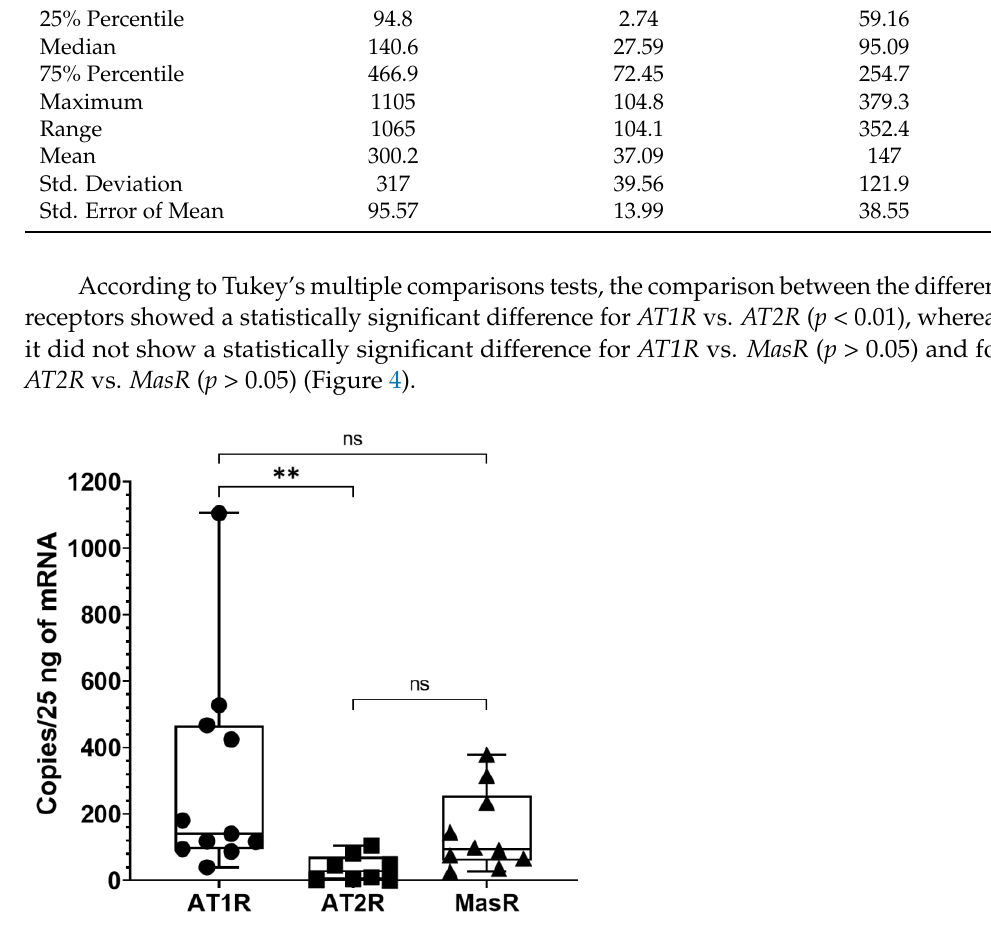
Figure 4. Gene expression of angiotensin receptors in human thoracolumbar fascia. The amount of the different angiotensin receptors ( AT1R, AT2R, MasR ) in thoracolumbar fascia was measured with ddPCR. The rank of expression of angiotensin receptors was AT1R > MasR > AT2R . In the table are reported the values obtained from ddPCR. Data are expressed as gene copies obtained from 25 ng of mRNA. **: p < 0.01; n.s.: not significant.